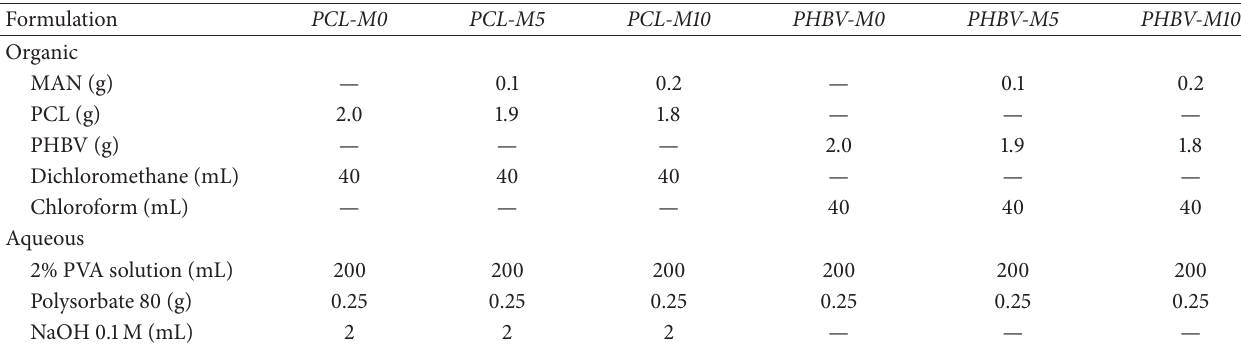
Table 1: Composition of manidipine-loaded and unloaded PCL/PHBV